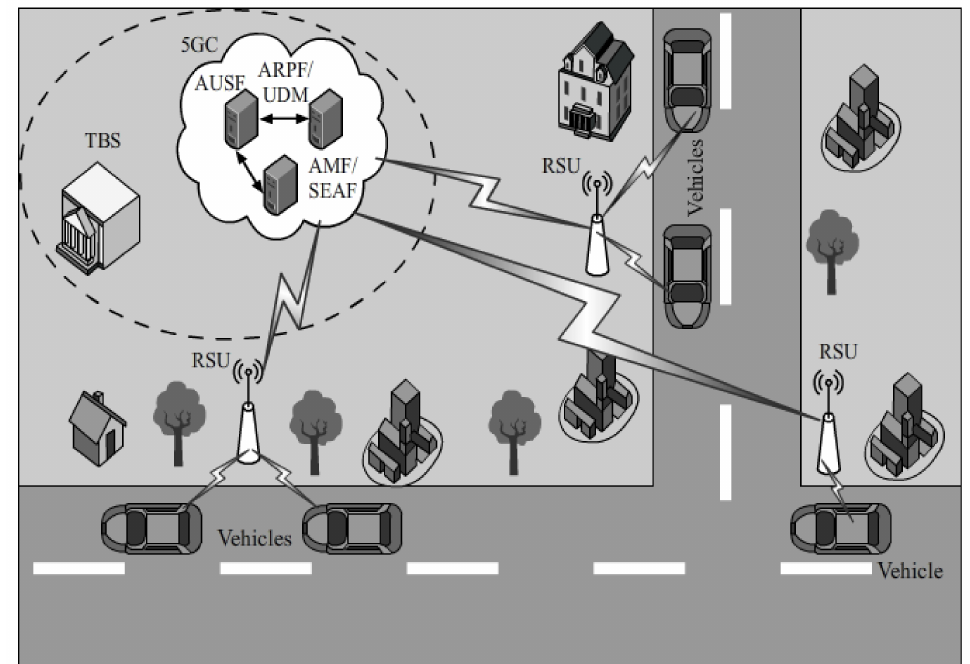
Figure 3. The System